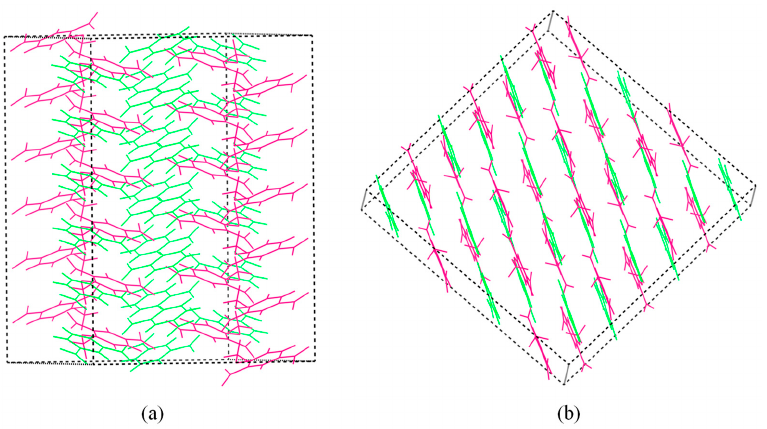
Figure 2. Crystal packing of the DNAN/DNB ( a ) and DNAN/NA ( b ) cocrystals. Pink and green represent DNAN and DNB or NA, respectively.